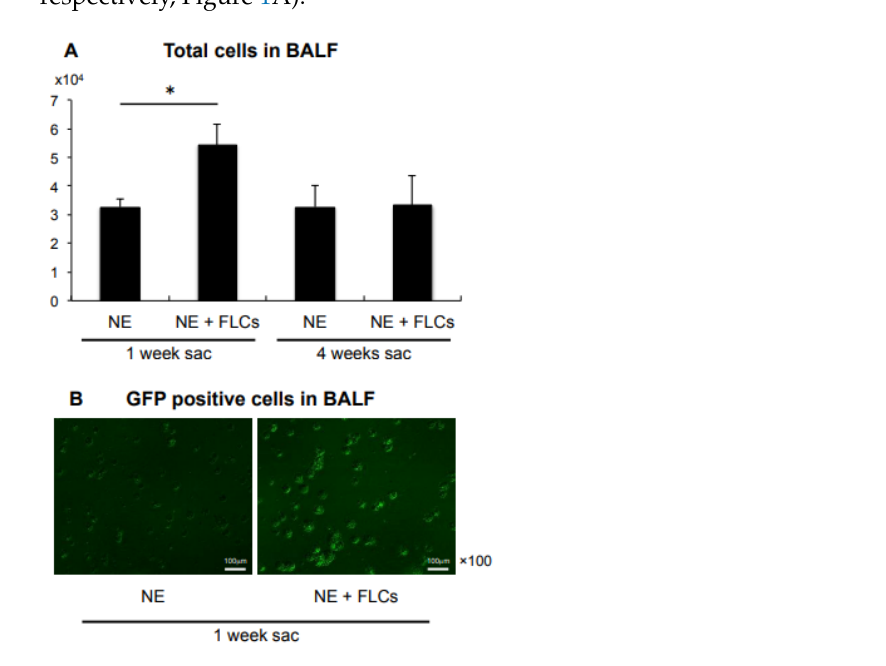
Figure 1. Analysis of total number of cells in the BALF at 1 week and 4 weeks after NE administra- tion. ( A ) Representative slides of BALF total cells showing under a fluorescence microscope from 1 week after the NE administration with or without FLCs transfer. ( B ) * p < 0.05, n = 6–8. BALF: bronchoalveolar lavage fluid, NE: neutrophil elastase, FLCs: fetal lung cells, sac: